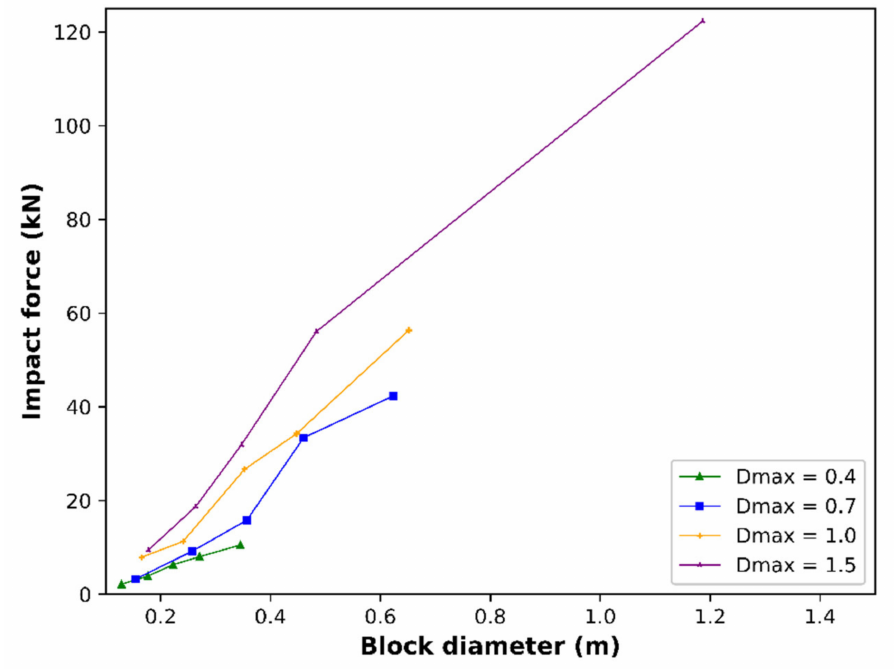
Figure 6. Maximal impact force versus block diameter for h = 1.5 m and v = 3